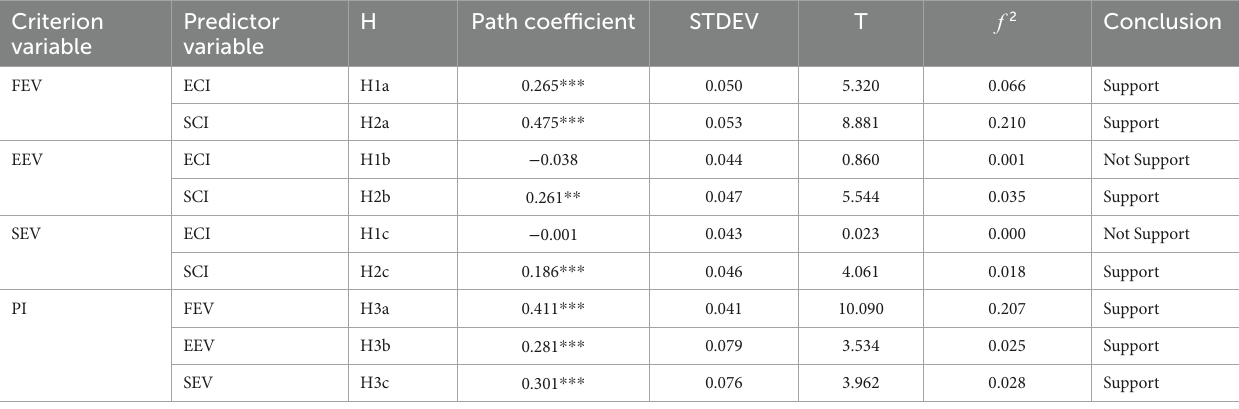
TABLE 5 Structural model results and effects sizes ( 2 f ).